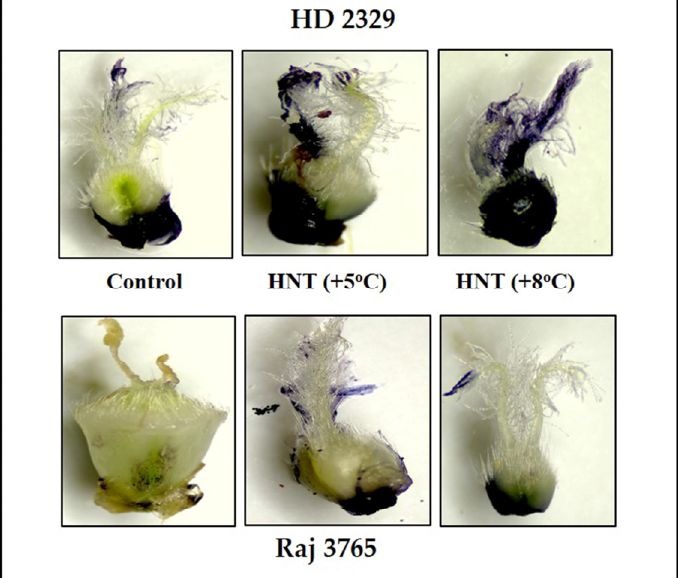
Figure 3. Photomicrographs showing superoxide anion (NBT staining) of pistil in HD2329 (sensitive) and Raj 3765 (tolerant) at control, HNT (+5 °C) and HNT (+8 °C) treatment.